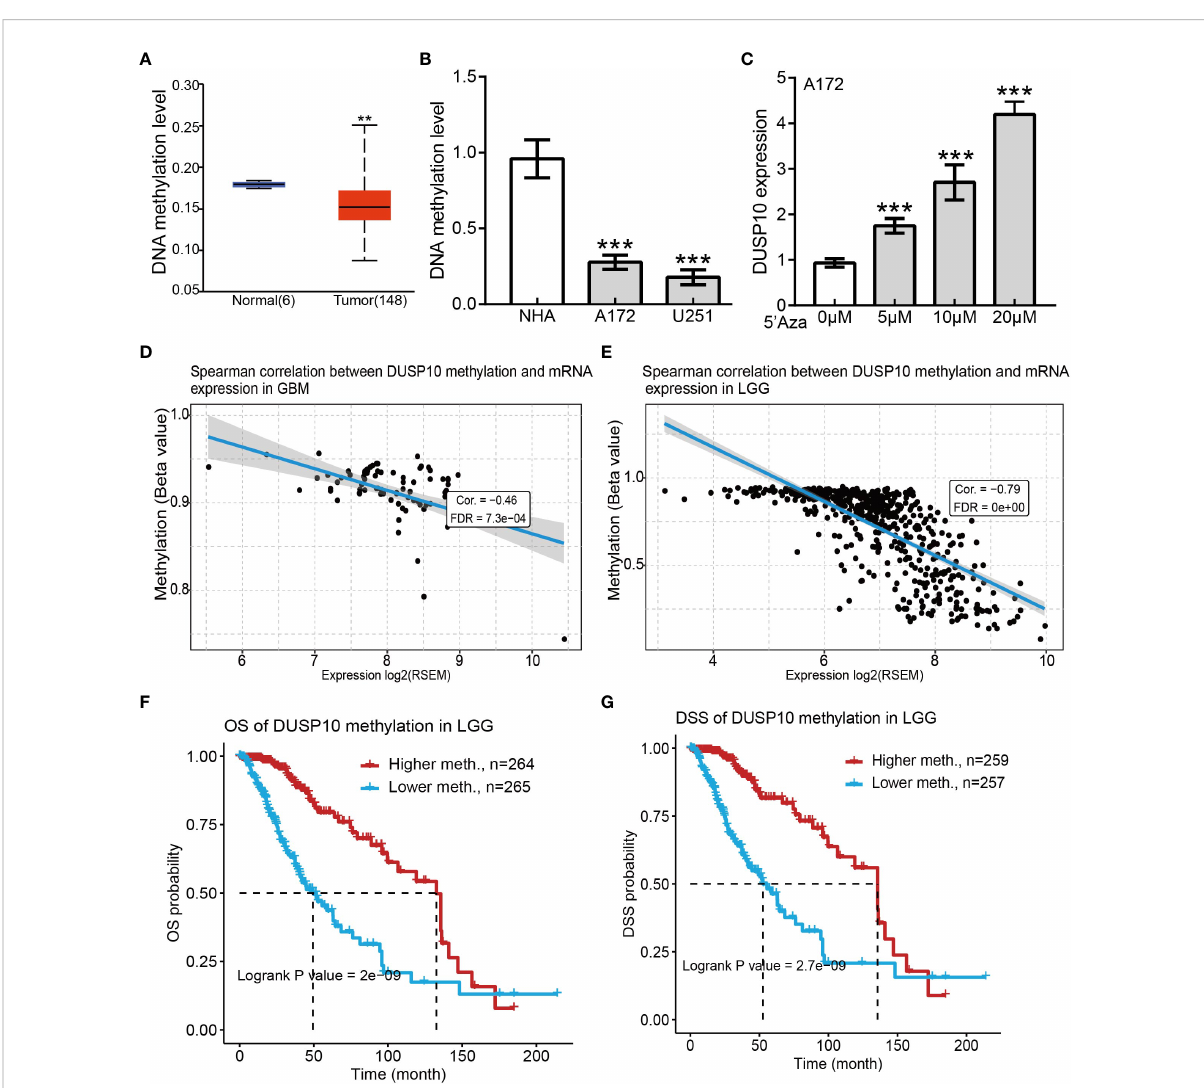
FIGURE 5 Correlations between DUSP10 mRNA expression and DNA Methylation based on GSCA. (A) Mean methylation levels of the DUSP10 promoter in glioma versus normal tissues in TCGA cohort. (B) Mean methylation levels of the DUSP10 promoter in glioma cells versus normal human astrocytes examined by Methy-PCR. (C) DUSP10 expression in A172 cells was signi fi cantly up-regulated in a dose-dependent manner after 5- azacytidine treatment. (D – E) DUSP10 expression negatively correlates with mean DUSP10 promoter methylation levels in TCGA cohort. (F-G) Correlation between DNA methylation and glioma patients clinical outcomes. ** p < 0.01, *** p < 0.001. GSCA, Gene Set Cancer Analysis; TCGA, The Cancer Genome